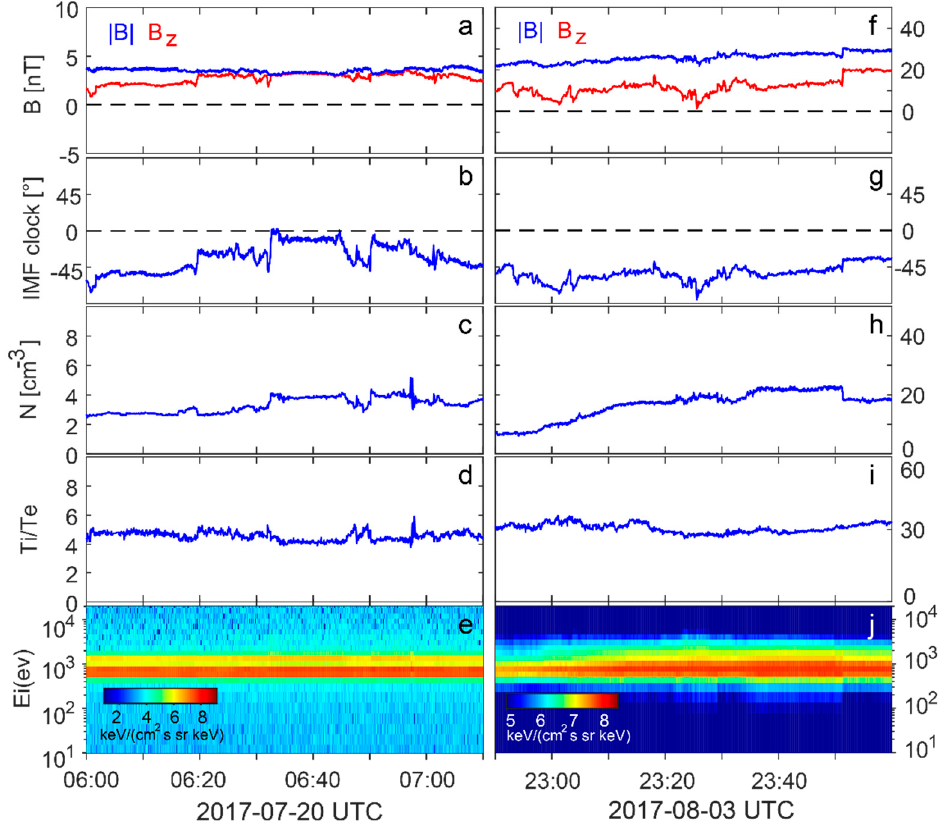
Figure 7. Parameters of the solar wind observed by ARTEMIS. On 20 July 2017: ( a )Magnetic field strength (blue) and magnetic field B z component (red); ( b ) Interplanetary magnetic field (IMF) clock angle; ( c ) ion number density; ( d ) the ratio of the ion to electron temperature; ( e ) ion differential energy flux (0.01–30 keV).On 3 August 2017: ( f ) Magnetic field strength (blue) and magnetic field B z component (red); ( g ) IMF clock angle; ( h ) ion number density; ( i ) the ratio of the ion to electron temperature; ( j ) ion differential energy flux (0.01–30 keV).